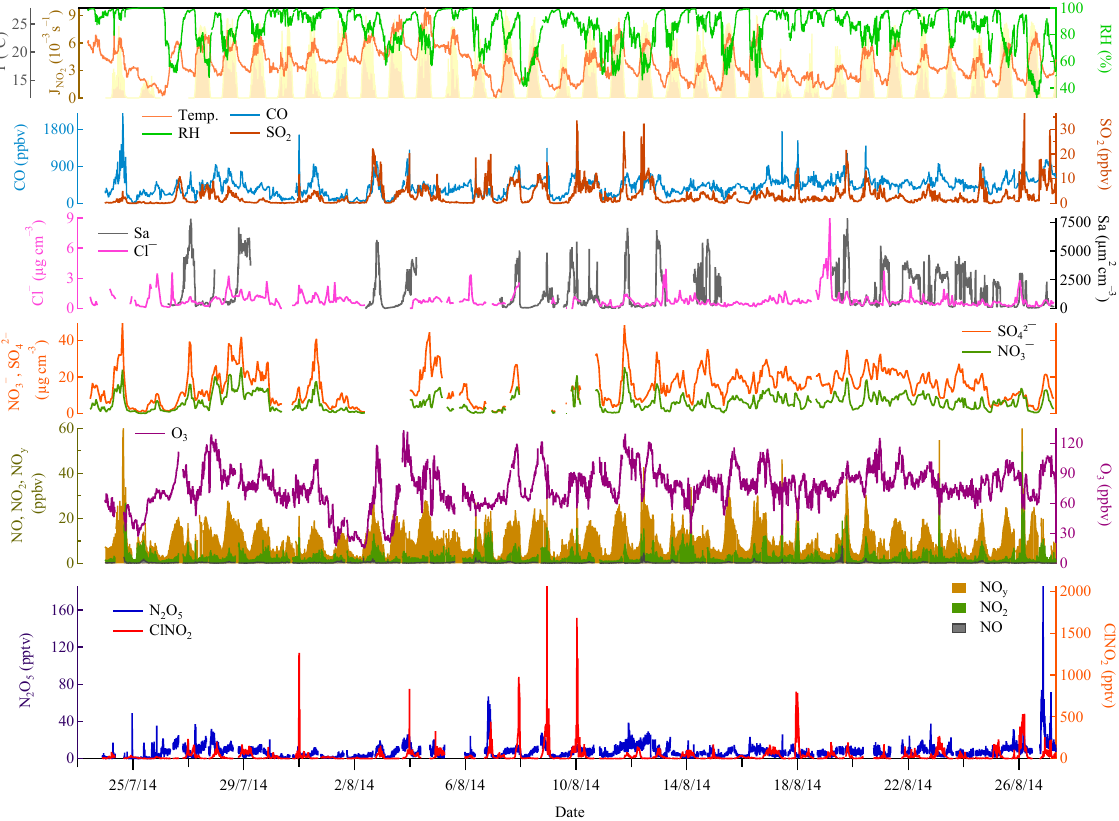
Figure 2. Time series for N 2 O 5 , ClNO 2 , related trace gases, aerosol properties, and meteorological data measured at Mt. Tai from 24 July to 27 August